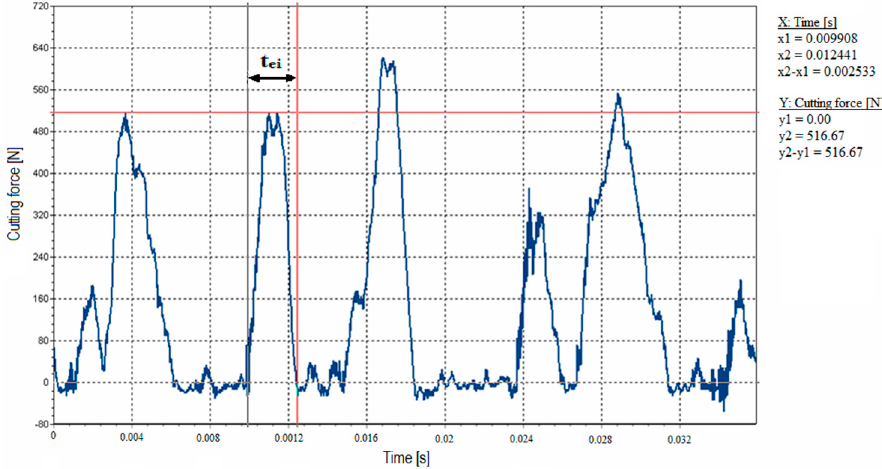
Figure 4. Cutting force plot with a duration of 0.036 s: t i —individual cutter engagement time.